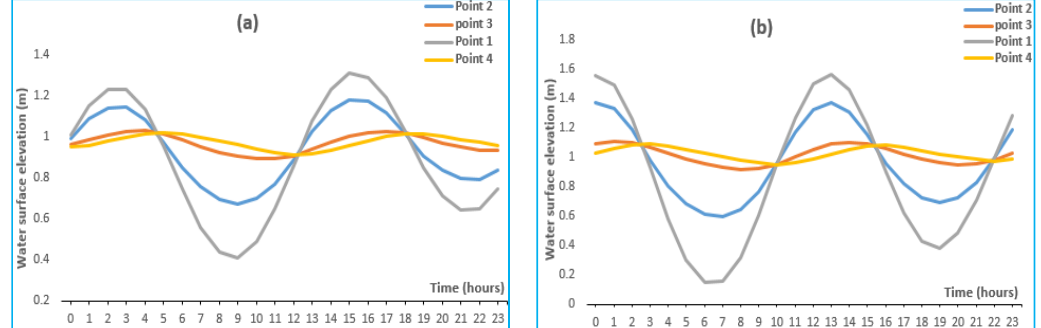
Figure 7. Variation of the water surface elevation simulated with average ( a ); and high ( b ) tidal amplitude in low water period.